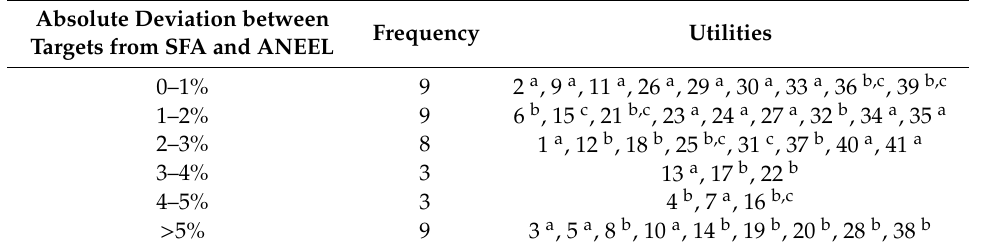
Table 4. Deviations between the targets from the ANEEL’s model and targets from SFA for 2018. Absolute Deviation between Frequency Targets from SFA and ANEEL